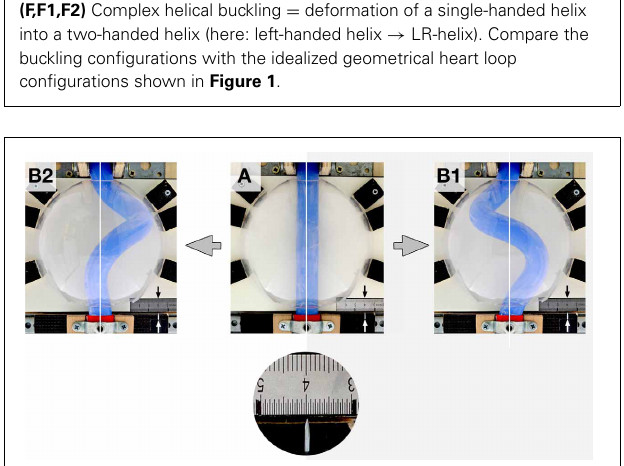
FIGURE 6 | These photographs taken at frontal views illustrate the fact that, under bilaterally symmetric conditions, helical buckling generated left- as well as right-handed helices. (A) “Intra-pericardial” portion of the silicone rod before starting of the buckling test. Note the midline position of the center axis of the straight silicone rod [midline marked by white lines and line 4 on the mm-scale (black arrow); position of the center axis of the “caudal” end is indicated by a metal pin pointing to the mm-scale (white arrow)]. (B1,B2) “Intra-pericardial” portion of the silicone rod during helical buckling. Photographs show a left-handed helix (B1) and a right-handed helix (B2) . Note that the center axes of the “cranial” and “caudal” ends of the silicone rod are still in their original midline